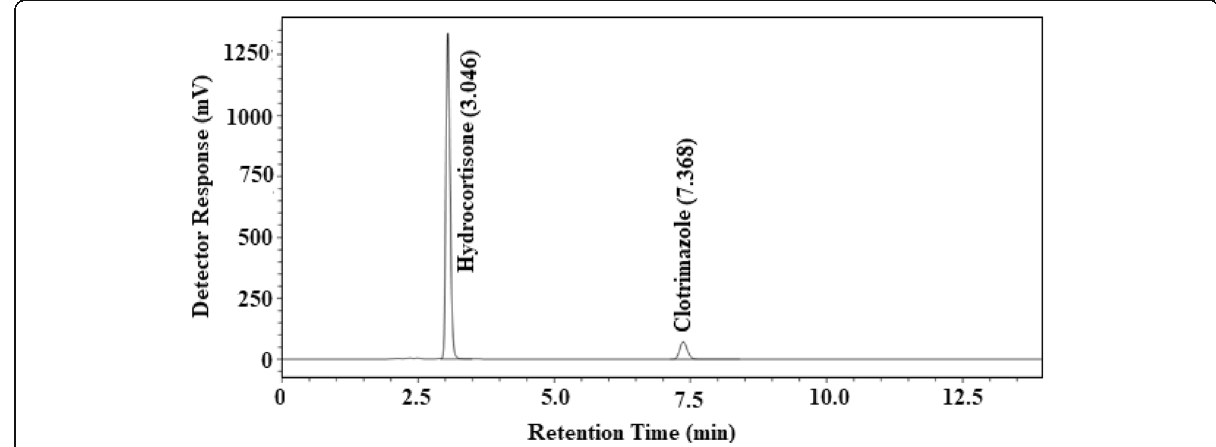
Fig. 2 HPLC chromatogram of working